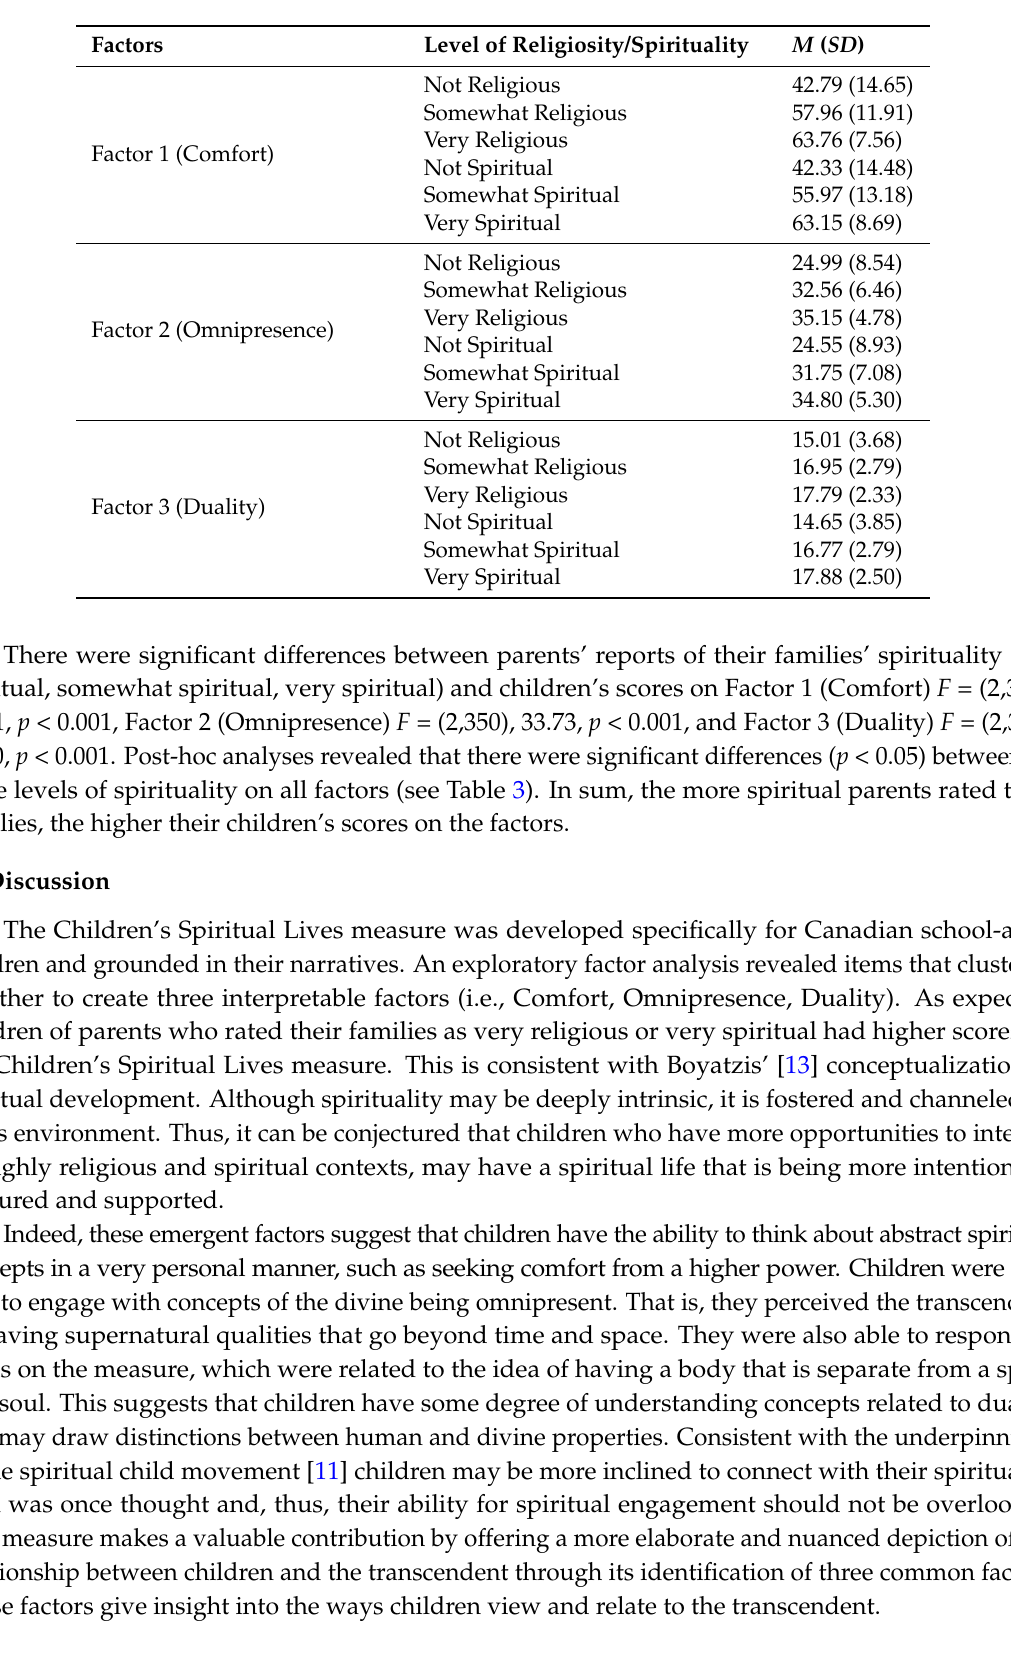
Table 3. Means and standard deviations by group (parent reported levels of religiosity and spirituality) on children’s factor composite